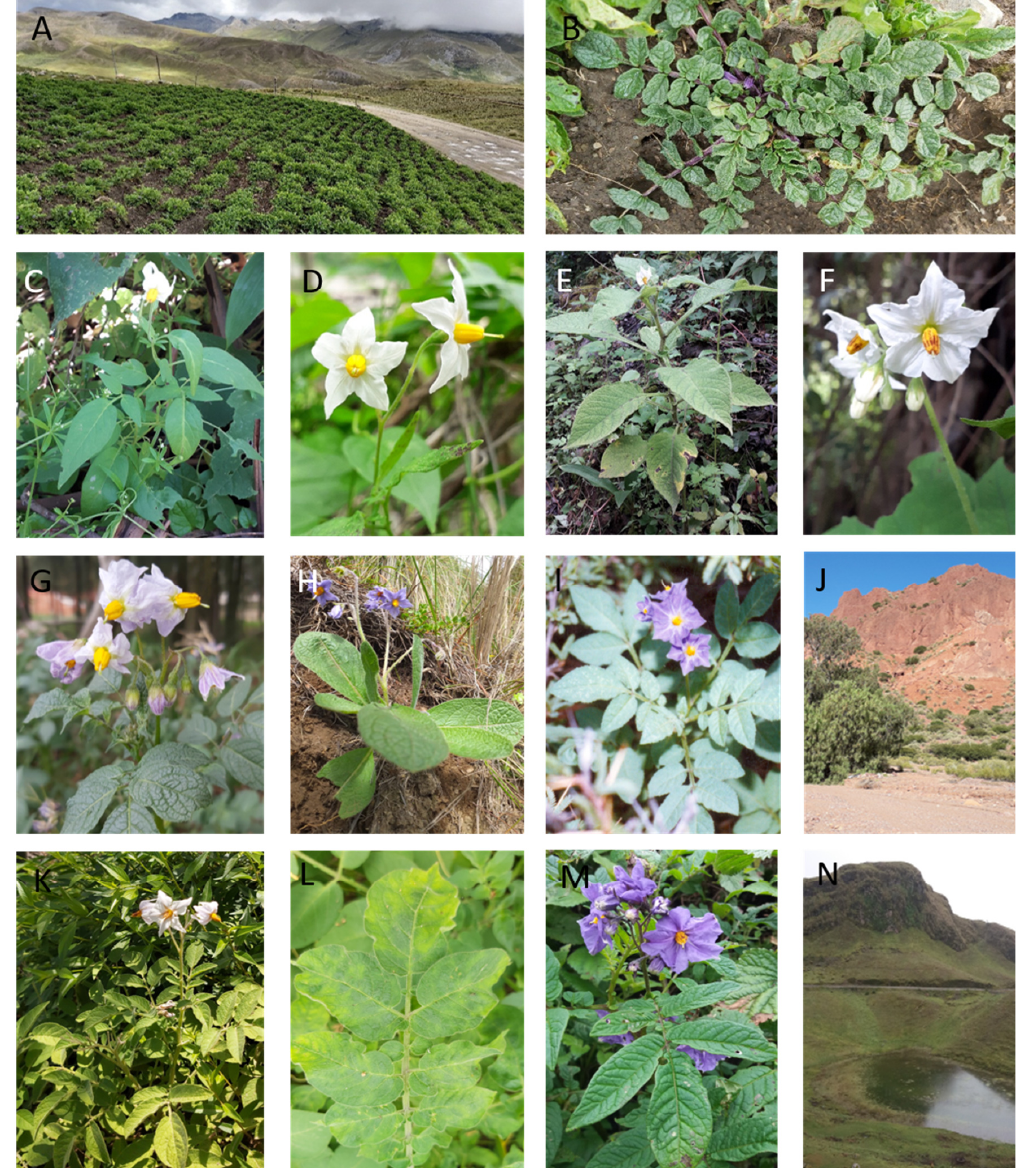
Figure 2. A: Smallholder plot whit potato luk’y variety ( S. × juzeckzukii ), Calientes locality; B: S. acaule